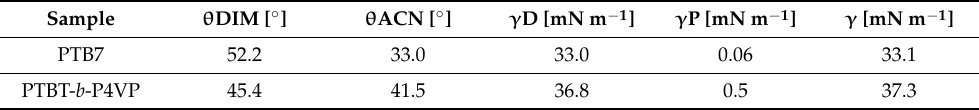
Table 2. Contact angles of DIM and acetonitrile ACN on PTB7 and PTB7-b-P4VP, dispersive compo- nent ( γ D), polar component ( γ P), and total surface energy ( γ ) for the two